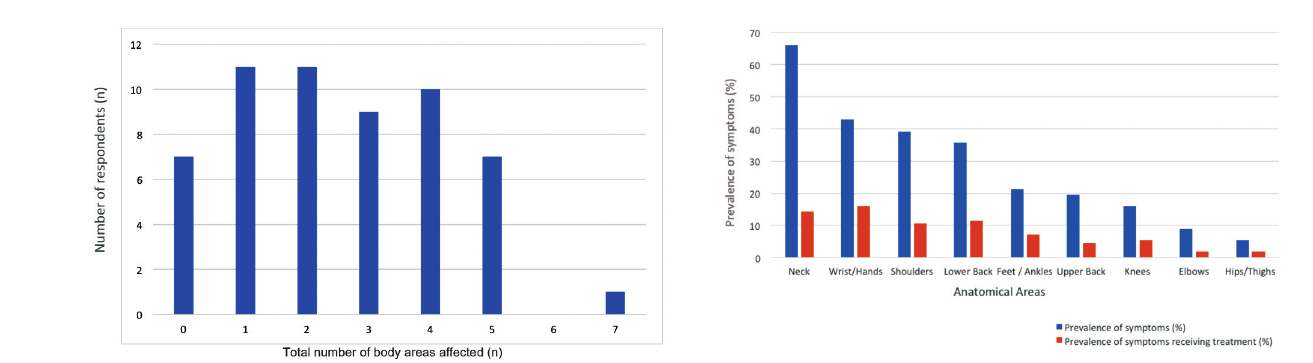
Number of respondents with total number of body areas Fig. 1: affected.